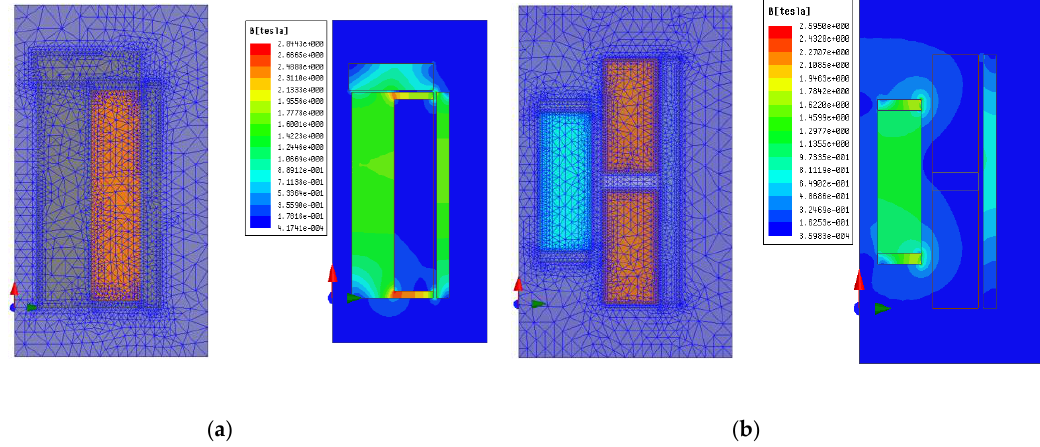
Figure 11. Meshed geometry and magnetic field distribution of models after modification. ( a ) SA model with 5118 mesh elements, and ( b ) MCA and MMA models with 8612 mesh elements.